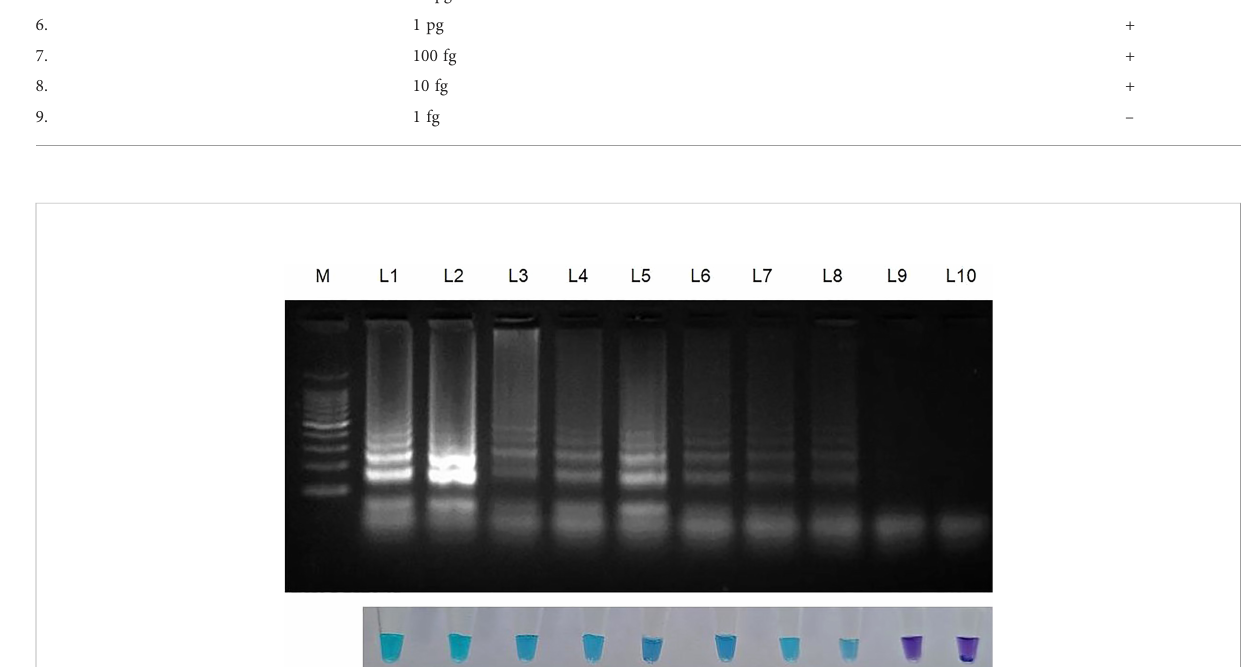
FIGURE 3 Sensitivity of LAMP assay using ten-fold serially diluted genomic DNA (from 100ng to 1 fg) from Sarocladium oryzae isolate OM841519 as template and nuclease free water as negative control. Upper panel in the fi gure shows agarose gel electrophoresis results whereas lower panel shows reaction tubes for colorimetric detection. M- 100bp Ladder; Lane 1: 100 ng; Lane 2: 10 ng; Lane 3: 1 ng; Lane 4: 100 pg; Lane 5: 10 pg; Lane 6: 1 pg; Lane 7: 100 fg; Lane 8: 10fg; Lane 9: 1 fg; Lane 10: Nuclease free water (Control).